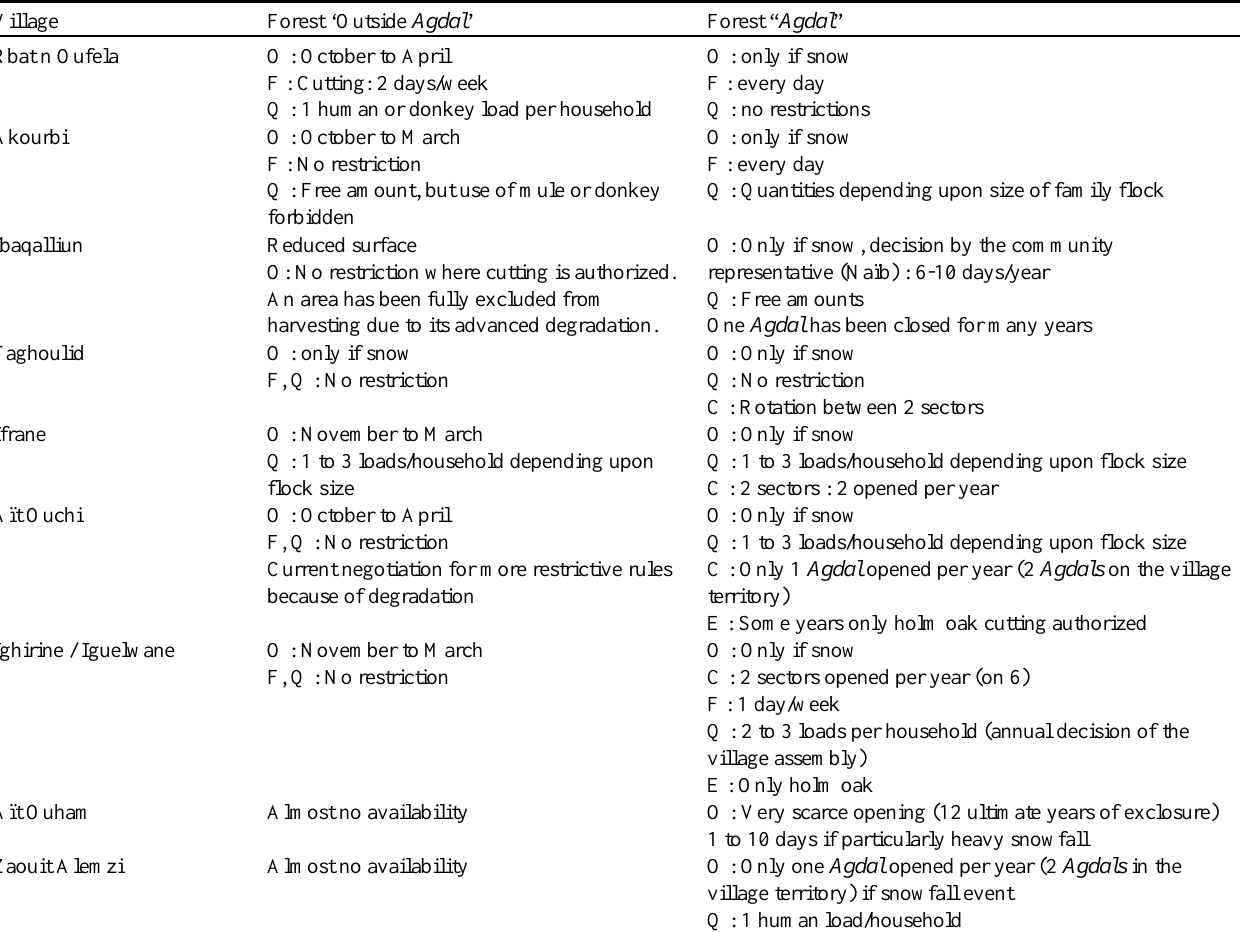
Table 2 . Diversity of village rules for tree foliage recollection in the upper valley of the Aït Bouguemmez (extracted from Cordier & Genin